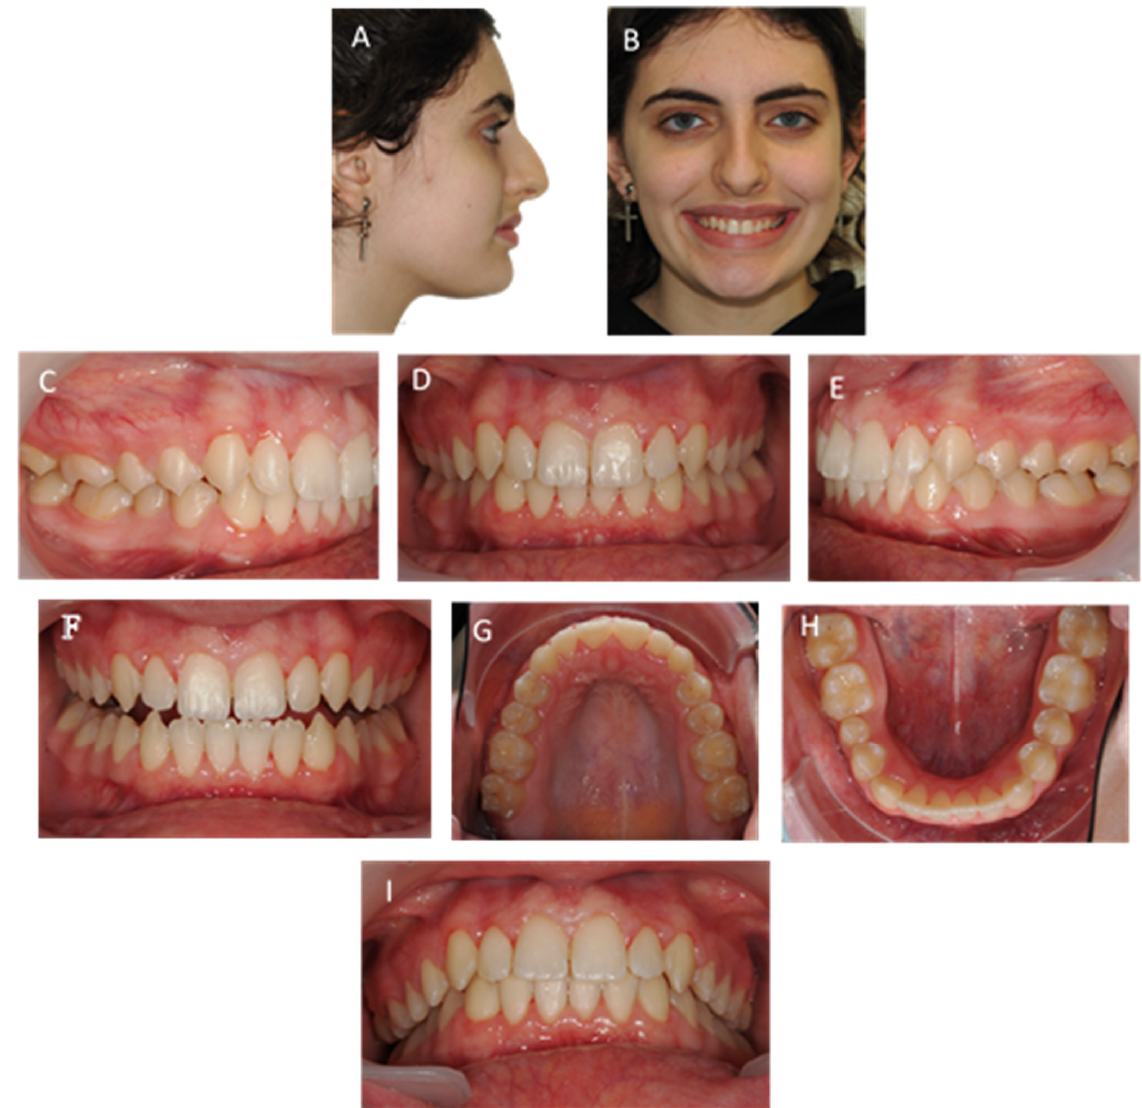
Figure 13. Final photographs, 3 years after the treatment began, including the use of aligners at night; ( A ) profile photo; ( B ) smile; ( C – E ) intra-oral photos in maximum intercuspation/centric relation; ( F ) protrusive guide; ( G , H ) occlusal photos; ( I ) overjet view. Through a panoramic X-ray, a satisfactory root parallelism was obtained (Figure